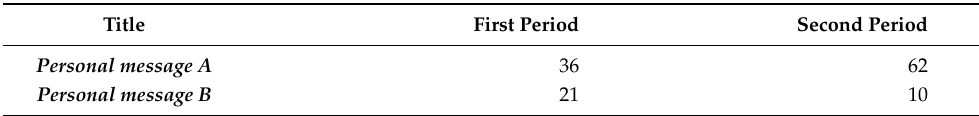
Table 7. Contingency table from Title in user I . This feature is considered as time-variant because p -value ≤